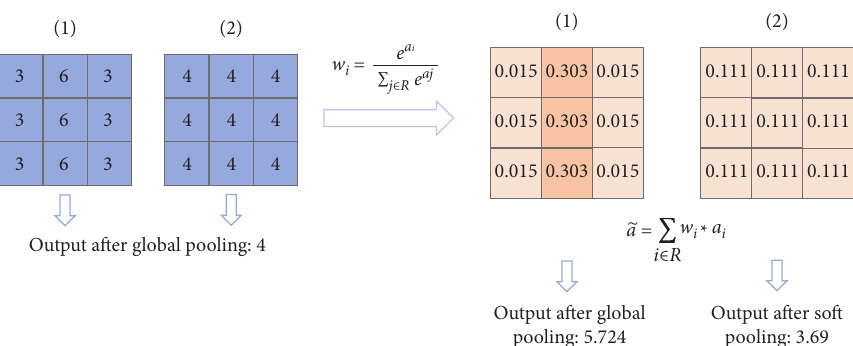
Figure 8: Calculation of global average pooling and soft